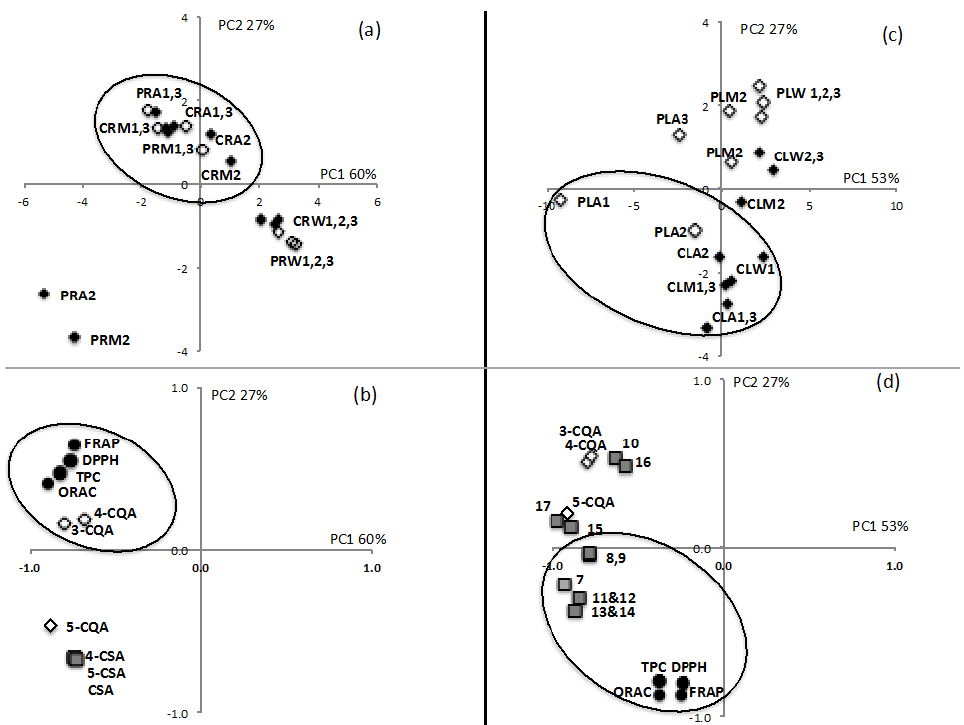
Figure 4. Principal component analysis plots for antioxidant activity and chemical composition of ( a , b ) root extracts and ( c , d ) leaflet extracts of Oenocarpus bacaba and Oenocarpus bataua . C: Comou ( Oenocarpus bacaba ), P: patawa ( Oenocarpus bataua ); R: roots; L: leaflets; W: water; A: acetone/water: 70/30; M: methanol/water: 70/30.